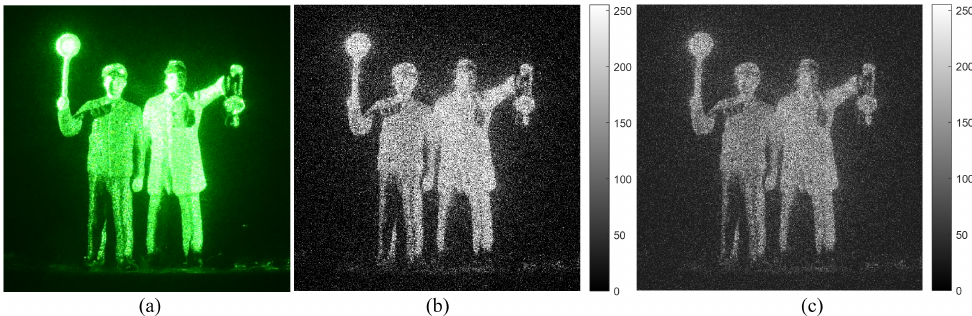
Figure 5. ( a ) Original image, ( b ) photon counting image by MLE, and ( c ) photon counting image by Bayesian estimation where 157,361 photons are extracted from the original image ( a